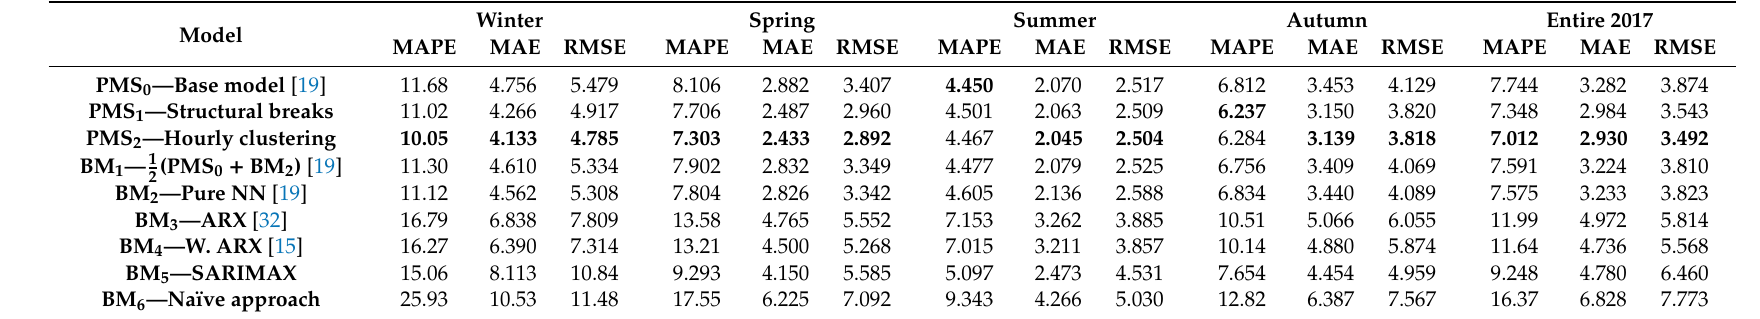
Table 1. Forecast error measures for the proposed and benchmark models: MAPE (%), MAE & RMSE ( € /